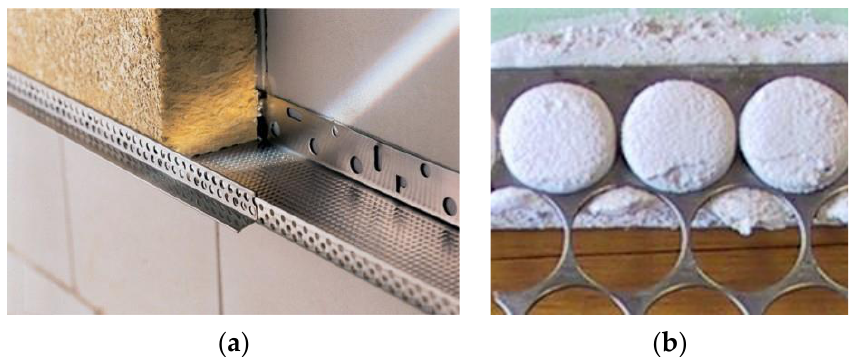
Figure 7. The solution for the partition wall construction using perforated steel profiles: ( a ) structural solution of self-bearing insulation panel with the framework of PMM-made perforated steel profiles, ( b ) plasterboard and perforated steel tape connecting with gypsum-based glue [41].